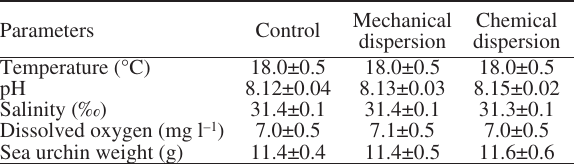
Table 2. – Sea urchin weight (values represent mean±SD; n=9 per treatment) and physicochemical parameters measured during organ- ism exposure (values represent mean±SD of 11 tank measurements at T=0